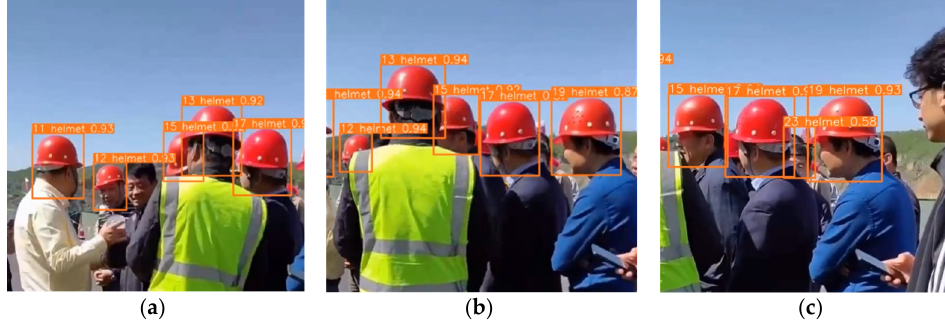
Figure 8. Tracking results of the same object person. ( a ) 10th second; ( b ) 15th second; ( c ) 25th second.